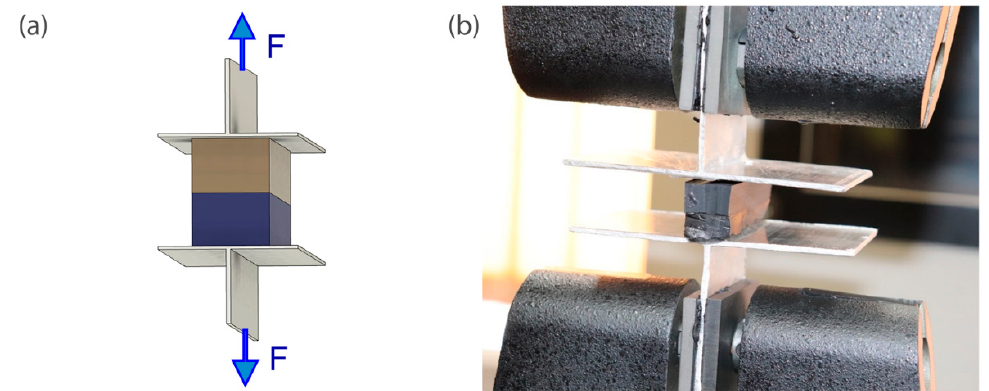
Figure 8. Detachment of PIB and silicone: ( a ) test set-up: ( b ) mounting of the specimen in the strength testing machine.